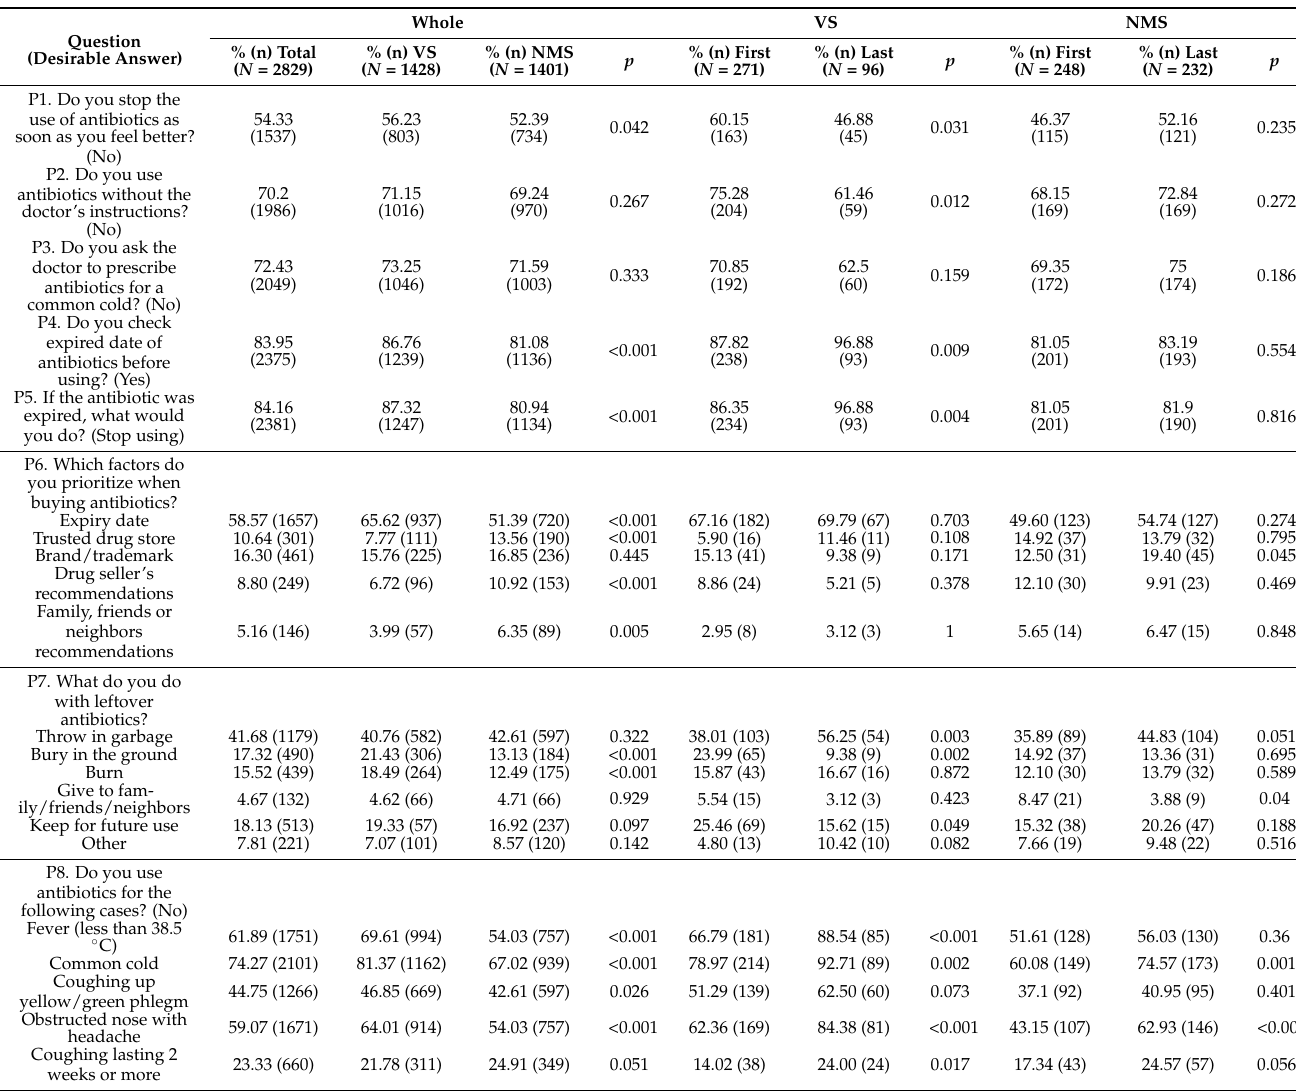
Table 6. Proportion of responses to questions about